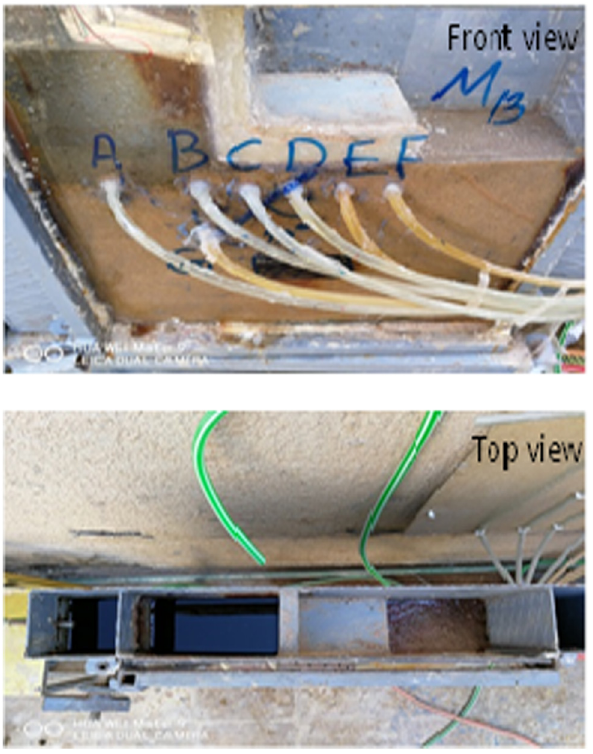
Figure 1: Images of laboratory model. Figure 2: Image of void